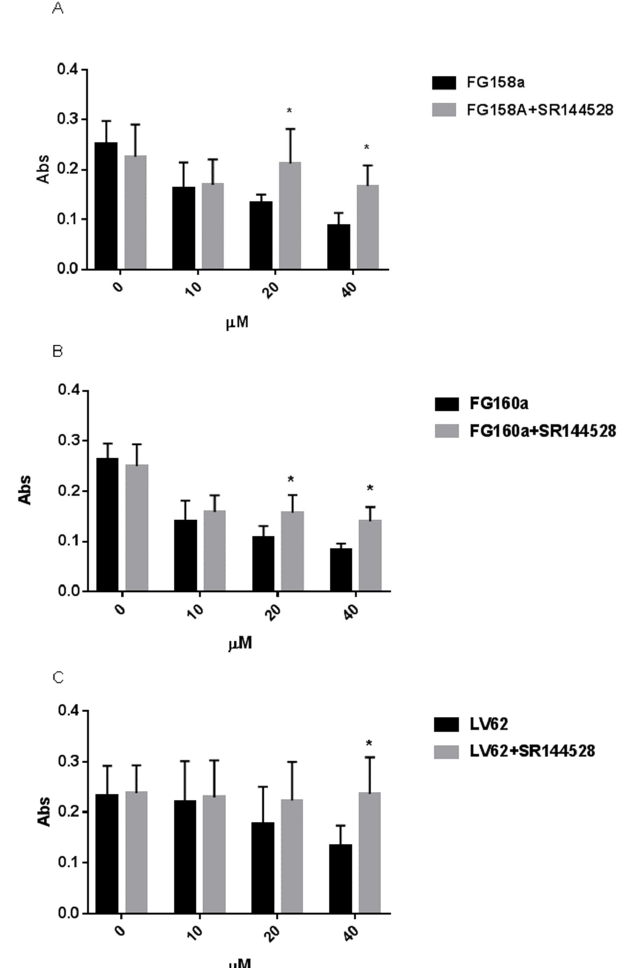
Figure 5. CB2R–mediated effect on cell viability. The effect on cell viability by selected CB2R ago- nists ( FG158a , FG160a , and LV62 ) at the concentrations reported in the histograms was explored in